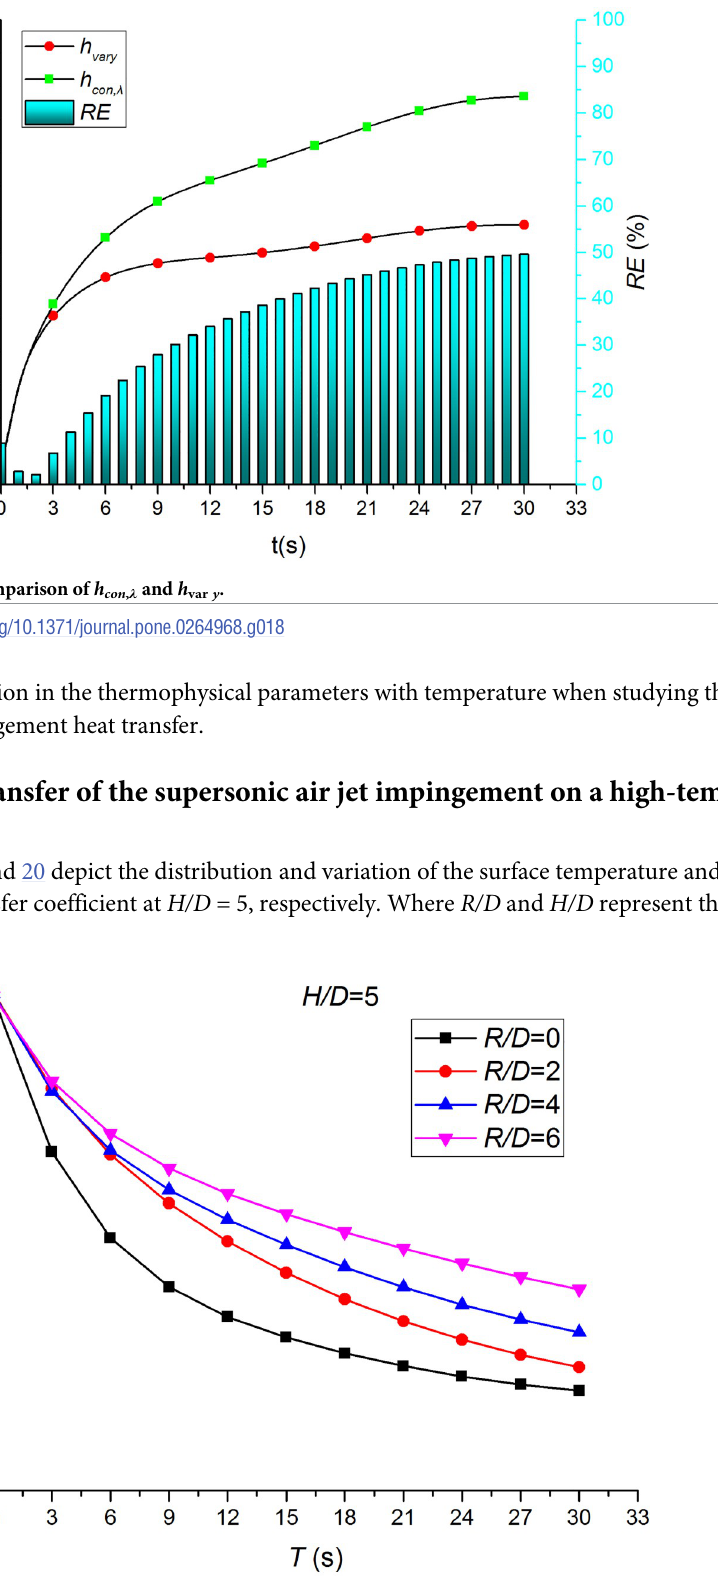
Fig 19. Distribution and variation of the surface